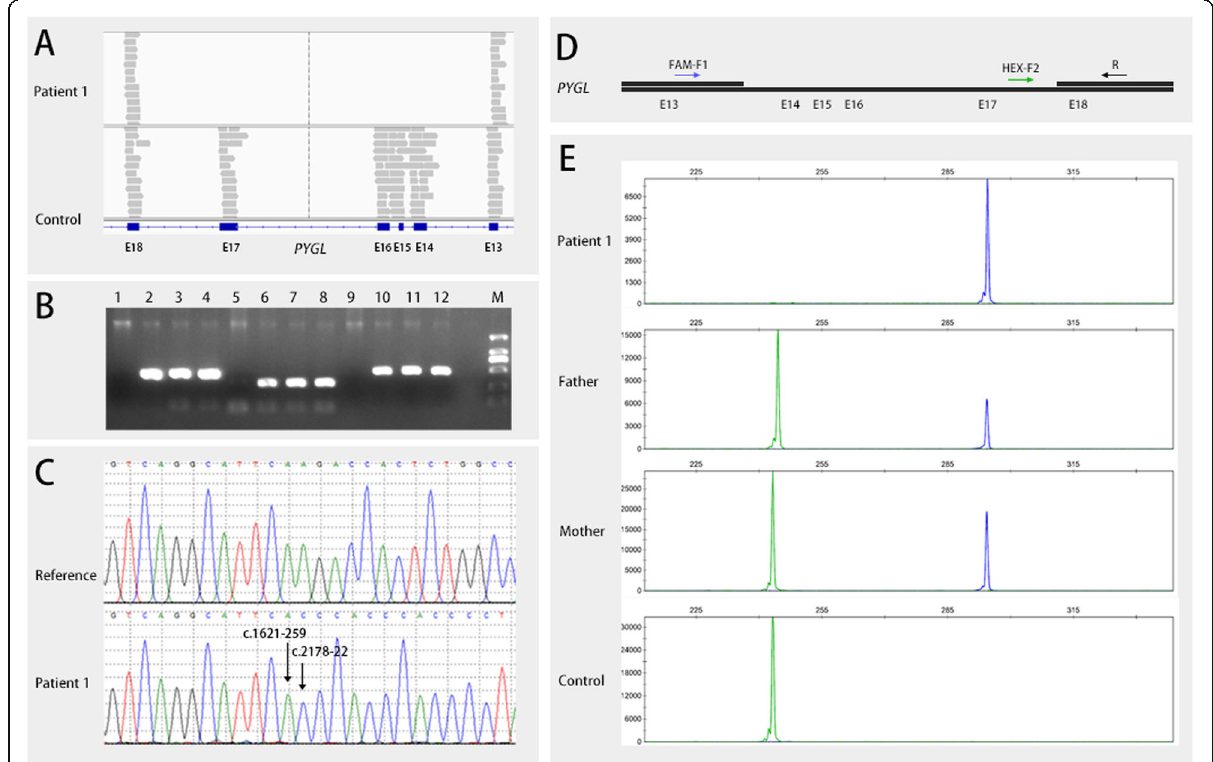
Fig. 1 Different methods used to confirm the gross deletion in patient 1. a Bam file of the proband showed the gross deletion including exons 14 to 17. b Agarose gel electrophoresis results verified the homozygous deletion of the proband. Lanes 1 – 12 contained PCR products for the proband (exons 14 – 15), father (exons 14 – 15), mother (exons 14 – 15), control (exons 14 – 15), proband (exon 16), father (exon 16), mother (exon 16), control (exon 16), proband (exon 17), father (exon 17), mother (exon 17) and control (exon 17), respectively. c Sanger sequencing revealed c.1621-258_2178-23del. d Schematic diagram of the three primers used in fluorescent gap PCR analysis. e Capillary electrophoresis of fluorescent gap PCR revealed the homozygous deletion in the proband and the heterozygous deletion in her